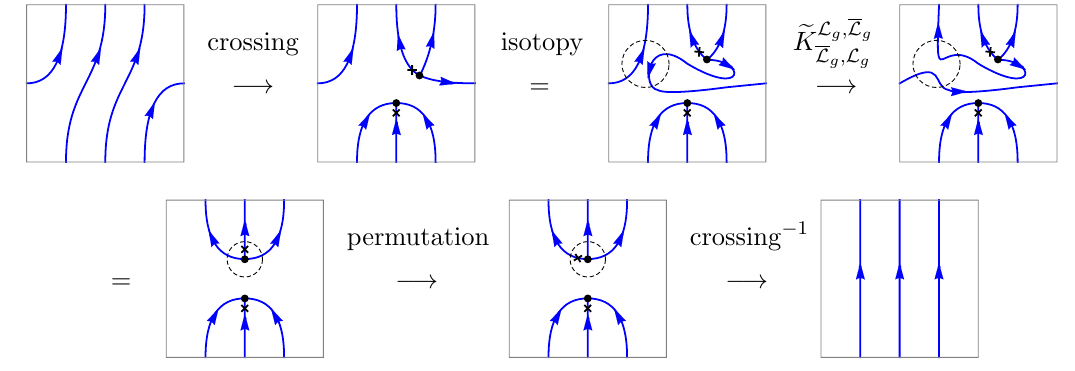
Figure 25 . Relating the cyclic permutation map b C on the cylinder to the H-junction crossing kernels. The crossing transformation in the (cid:12)rst and last steps are precisely the inverse of one another, with the speci(cid:12)ed ordering of legs speci(cid:12)ed by the \ (cid:2) ". Note that in the (cid:12)rst and the last step, a certain crossing kernel involving trivial junction and its inverse are applied, respectively. In going to the second line, the horizontal loop is removed because it acts trivially on the bulk ground